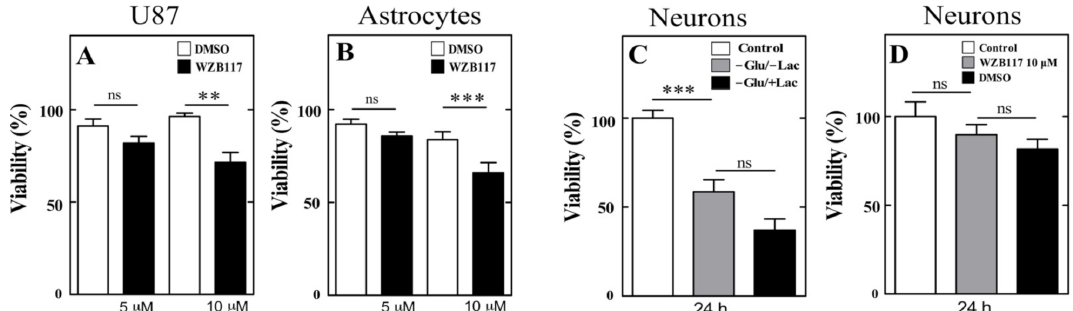
Figure 6. Viability analysis in U87 cells, astrocytes and neurons treated with WZB117, a GLUT1 inhibitor. ( A , B ) Cell viability analysis using the XTT method in U87 cells and astrocytes exposed to 5 or 10 µ M WZB117 or DMSO. The analyses were carried out after 24 h of incubation with WZB117. ( C ) Viability analysis using the XTT method in 7 DIV cortical neurons incubated with 25 mM glucose (control), without glucose and lactate ( − Glu/ − Lac) or without glucose and 5 mM lactate ( − Glu/+Lac) for 24 h. ( D ) Viability analysis performed on cortical neurons treated with 10 µ M WZB117 or DMSO for 24 h. Statistical analysis ANOVA, followed by Tukey test. ** p < 0.01; *** p < 0.001. The data represent the means ± SEM of three